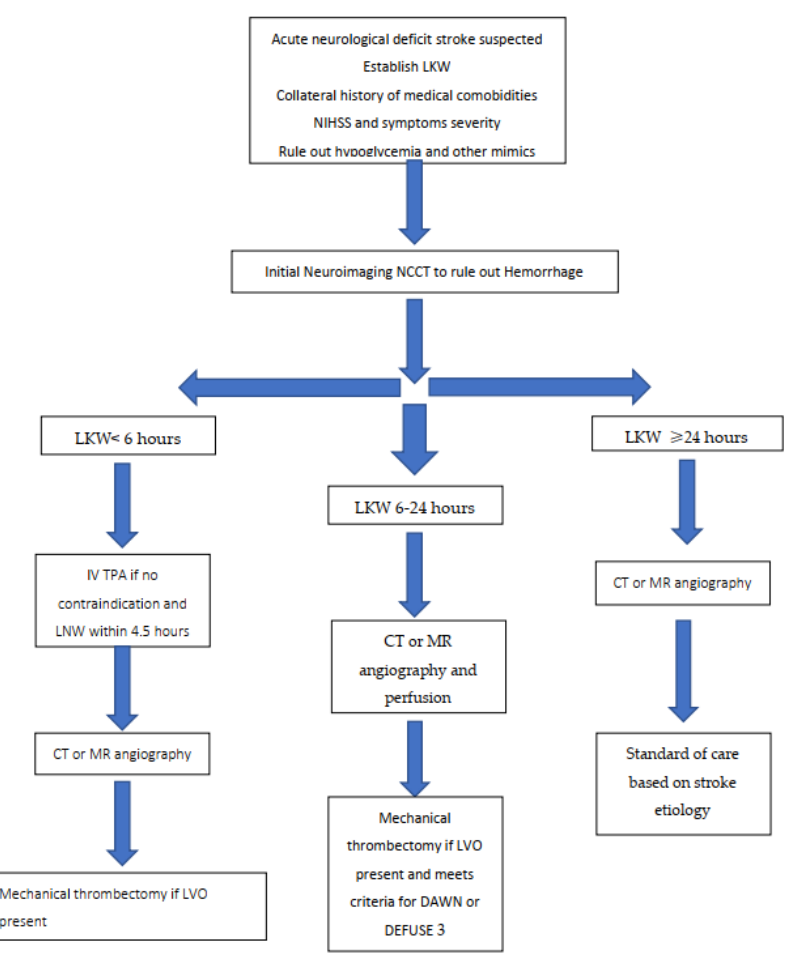
Figure 1. Stepwise Algorithm for Initial Management of Acute Ischemic Stroke in Adults.